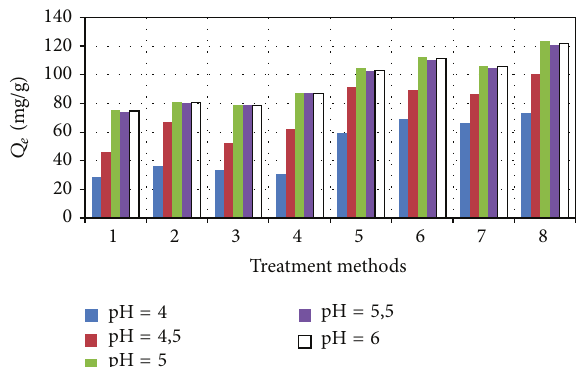
Figure 1: Adsorption capacities of the AC samples obtained by the chemical treatment followed by pyrolysis at 250 or 700 ∘ C (conditions: 𝐶 𝑜 : 100mg/L, particle size: 180–300 𝜇 m, adsorbent dosage: 1g/L, mixing speed: 150rpm, mixing time: 60 min, and temperature: 20 ∘